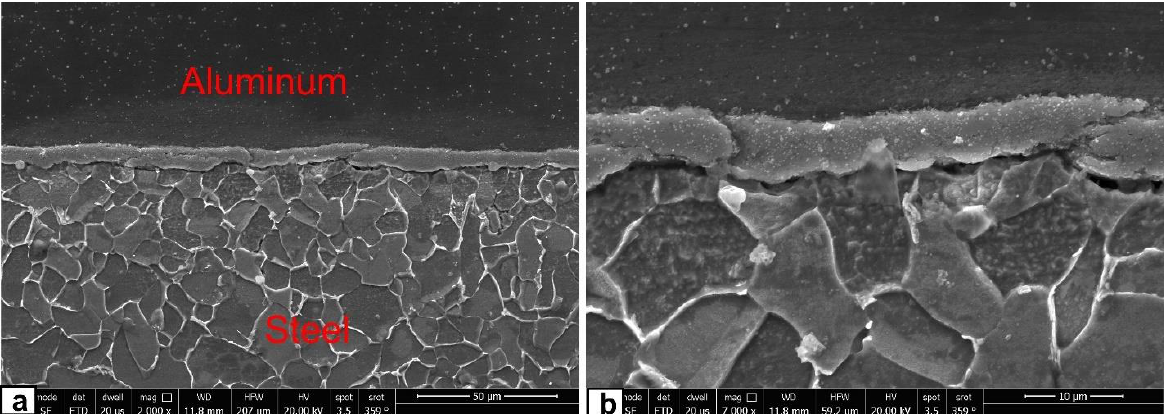
Figure 9. SEM Micrographs of the aluminum/steel interface produced with low FSP rotation speed of 500 rpm and pin length of 3 mm: ( a ) steel – aluminum interface; ( b ) magnified image of the inter- face.